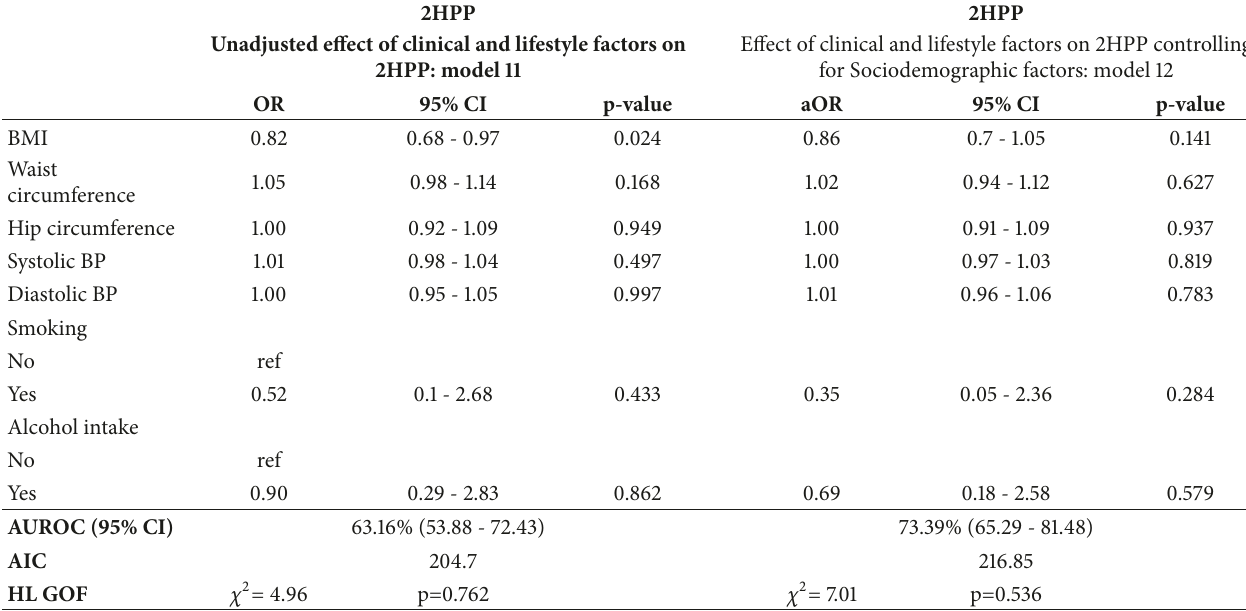
Table 5: Evaluating the effect of clinical and lifestyle factors on 2HPP. Unadjusted effect of clinical and lifestyle factors on 2HPP: model 11